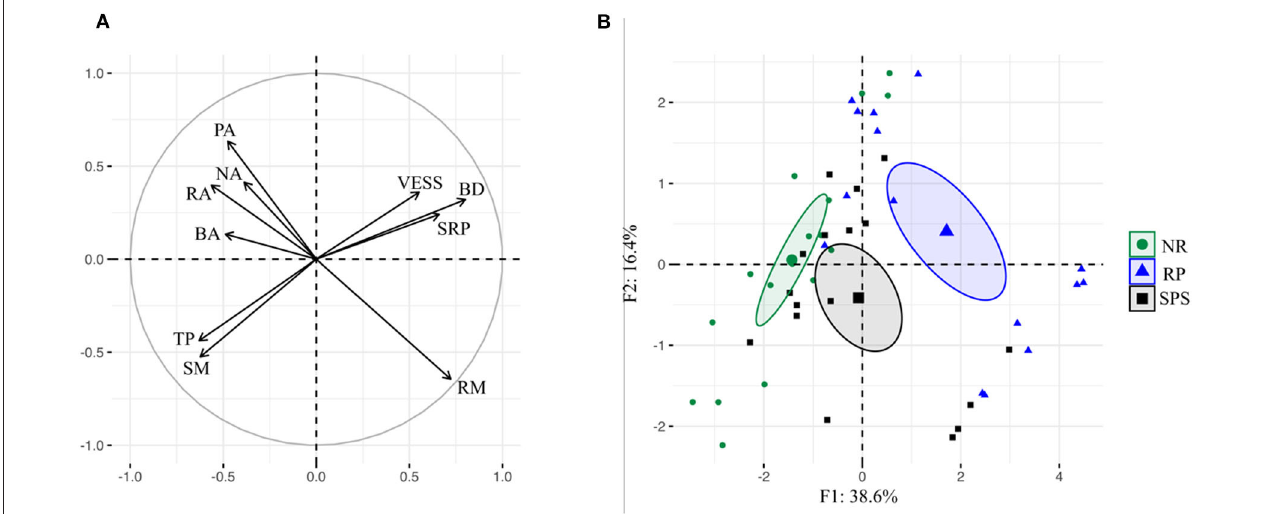
FIGURE 4 | Projection of physical soil characteristics and the 60 sampling points according to land uses (A) , and in the plane formed by Axes 1 and 2 of PCA (B) in Colombian Amazon region. Ellipses show sampling points grouped from a given land use centered on their respective bari-centers ( P < 0.01: Monte Carlo permutation test, Explained variance: 21.24%). BA, biogenic aggregates; BD, bulk density; NA, soil not macro-aggregate; PA, physical aggregates; RA, root aggregates; RM, remaining material; SRP, soil resistance to penetration; TP, total porosity; VESS, visual evaluation of soil structure.